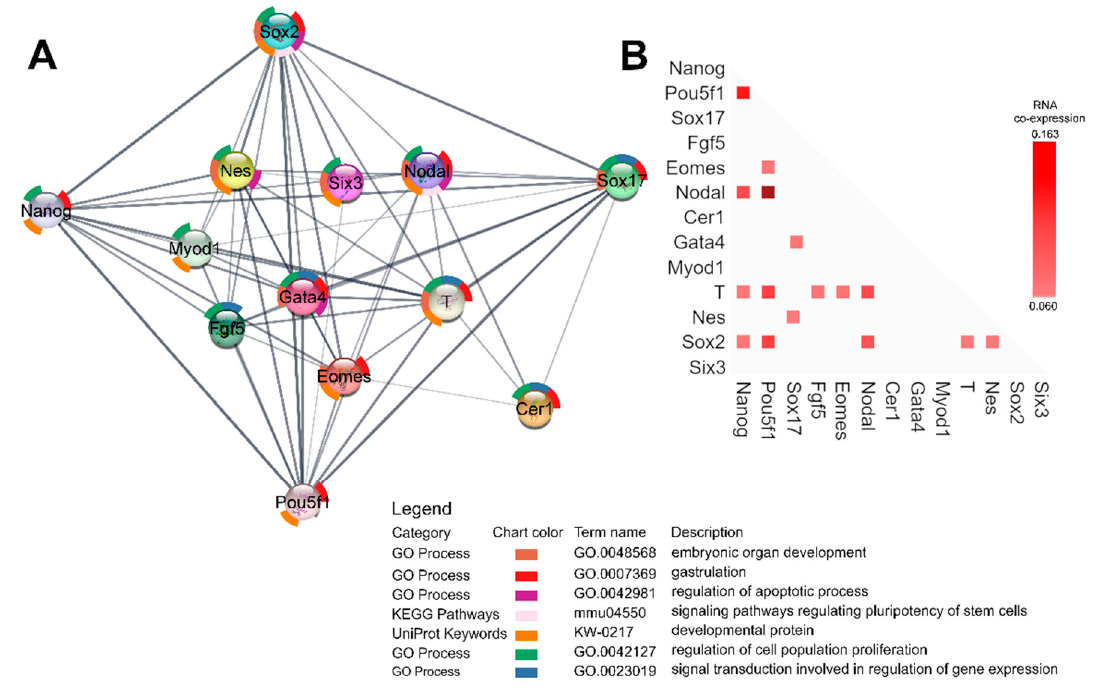
Figure 8. ( A ) STRING functional gene analysis using Cytoscape. Each node represents a protein product of an investigated gene. Lines denote protein–protein interactions, with line thickness being indicative of evidence strength for a predicted interaction. ( B ) RNA co-expression, by STRING v11. Each node represents evidence of intersecting genes’ RNA co-expression. Scores are represented with lighter hues of red for weaker and darker hues for stronger.